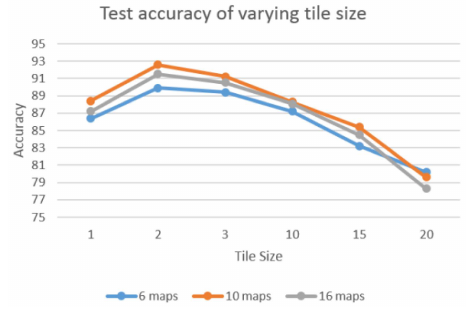
Figure 8. Test accuracy of varying tile size with fixed number of local maps (16).